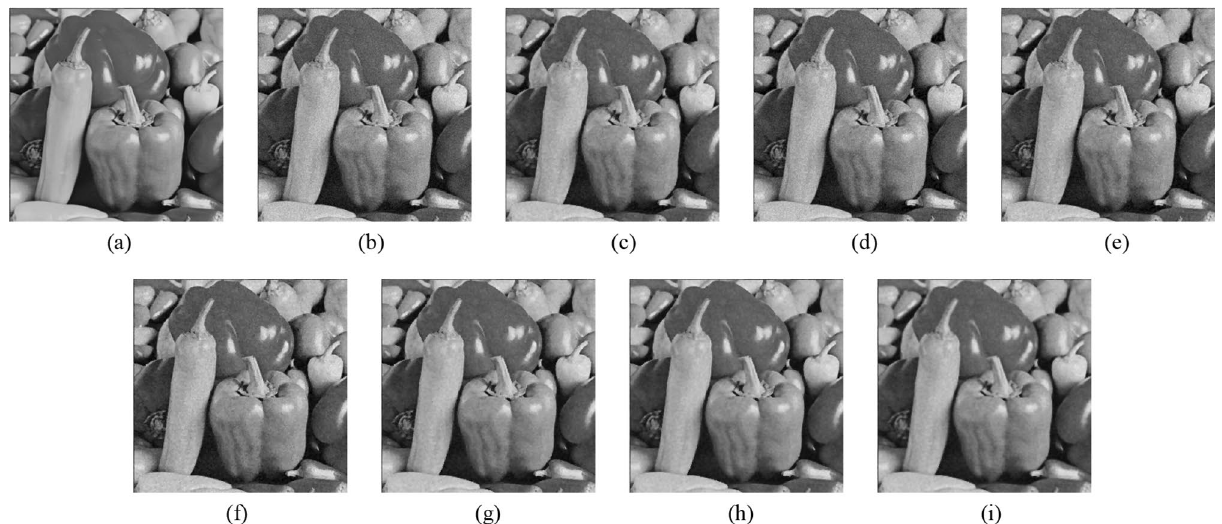
Figure 26. Comparison of denoising performance of each filter against the Gaussian noise (“Pepper”). ( a ) Original image; ( b ) noise-added image; ( c ) filtered image using abwFMGFI; ( d ) filtered image using FMGFI (BW = 1 level); ( e ) filtered image using FMGFI (BW = 3 level); ( f ) filtered image using FMGFI (BW = 5 level); ( g ) filtered image using FMGFI (BW = 11 level); ( h ) filtered image using FMGFI (BW = 21 level); ( i ) filtered image using FMGFI (BW = 51 level).